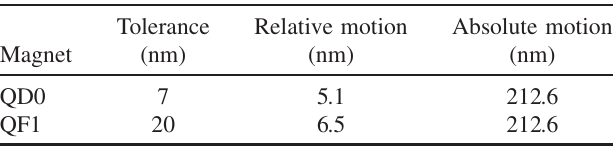
TABLE II. Root-mean square vertical motion of QD0 and QF1 magnets relative to the top of the BSM rigid mount support, for frequencies between 0.2 and 100 Hz. The absolute motion is the coherent movement of both magnets and of the BSM